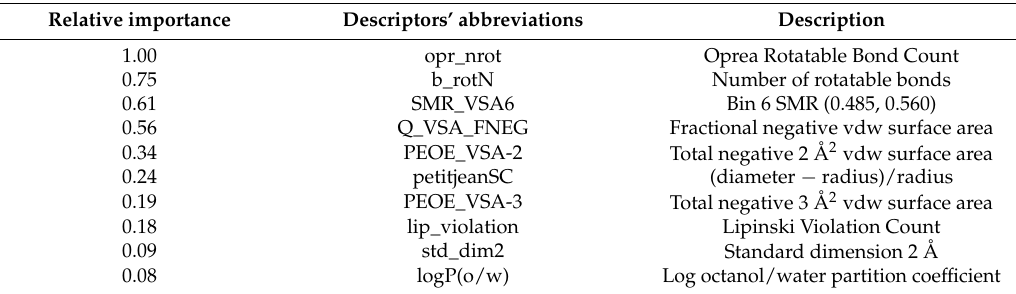
Table 5. The linear model equation produced from the model and the relative importance of each